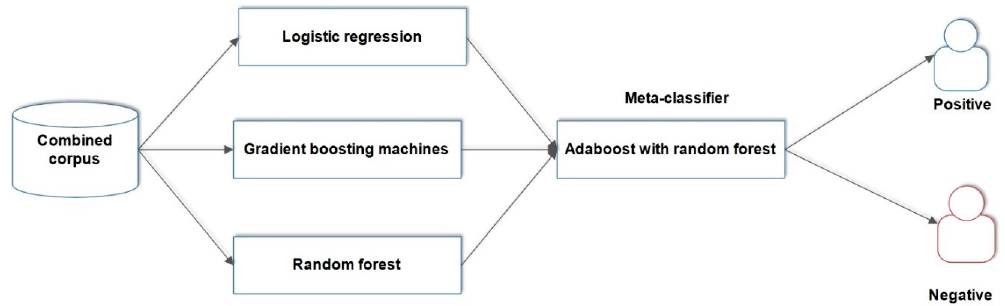
Figure 5. Architecture of RALOG ensemble learning algorithm: a combination of random decision forest, AdaBoost, logistic regression, and gradient boosting machine.